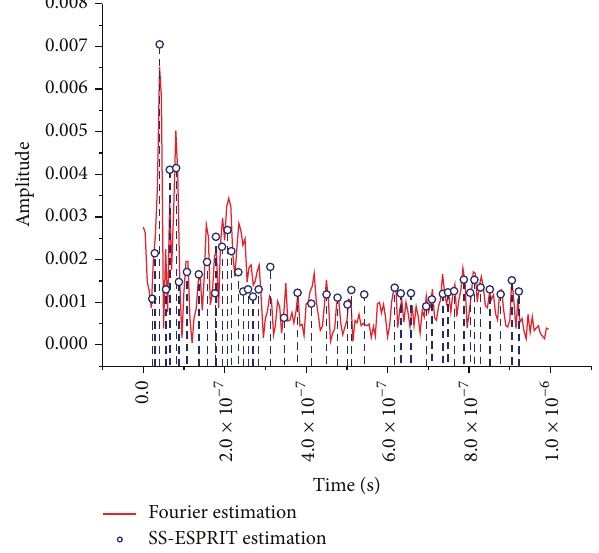
Figure4:ComparisonofFourierandSS-ESPRITestimatedimpulse responses at 900 MHz, 11m, in Scenario 1.